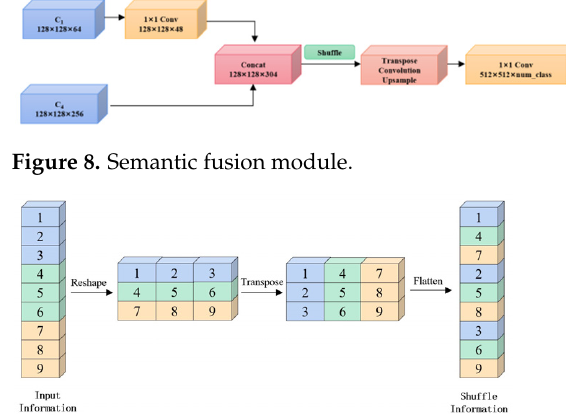
Figure 9. Shuffle. Figure 9. Shuffle.